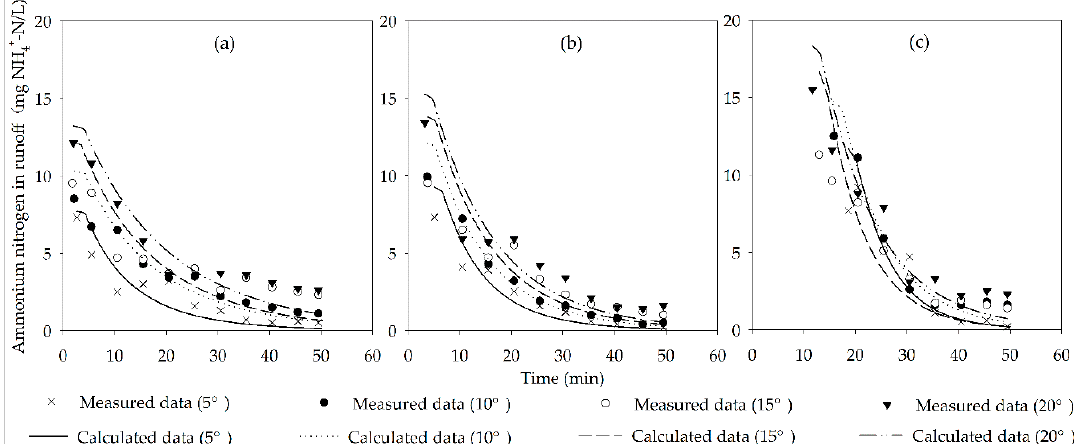
Figure 5. Comparison of the calculated and experimental ammonium nitrogen (NH 4+ -N) concentration in the runoff under different slope gradients and different rainfall intensities: ( a ) 75 mm/h, ( b ) 50 mm/h, ( c ) 25 mm/h.